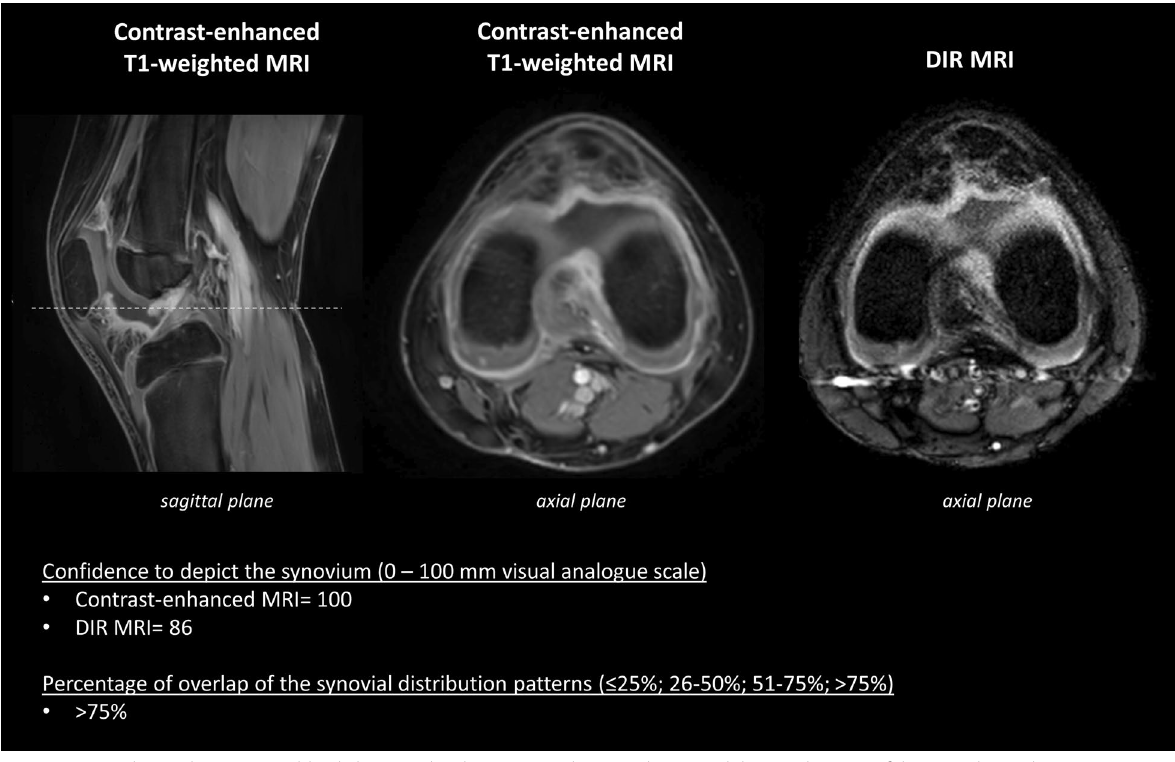
Fig. 3 Images obtained in a 9‑year‑old girl, diagnosed with persistent oligoarticular JIA, with knee arthritis. Confidence to depict the synovium was 100 (0–100 mm visual analogue scale) for the axial contrast‑enhanced MRI and 86 (0–100 mm visual analogue scale) for the axial DIR MRI. The percentage of overlap of synovial distribution patterns was scored as >